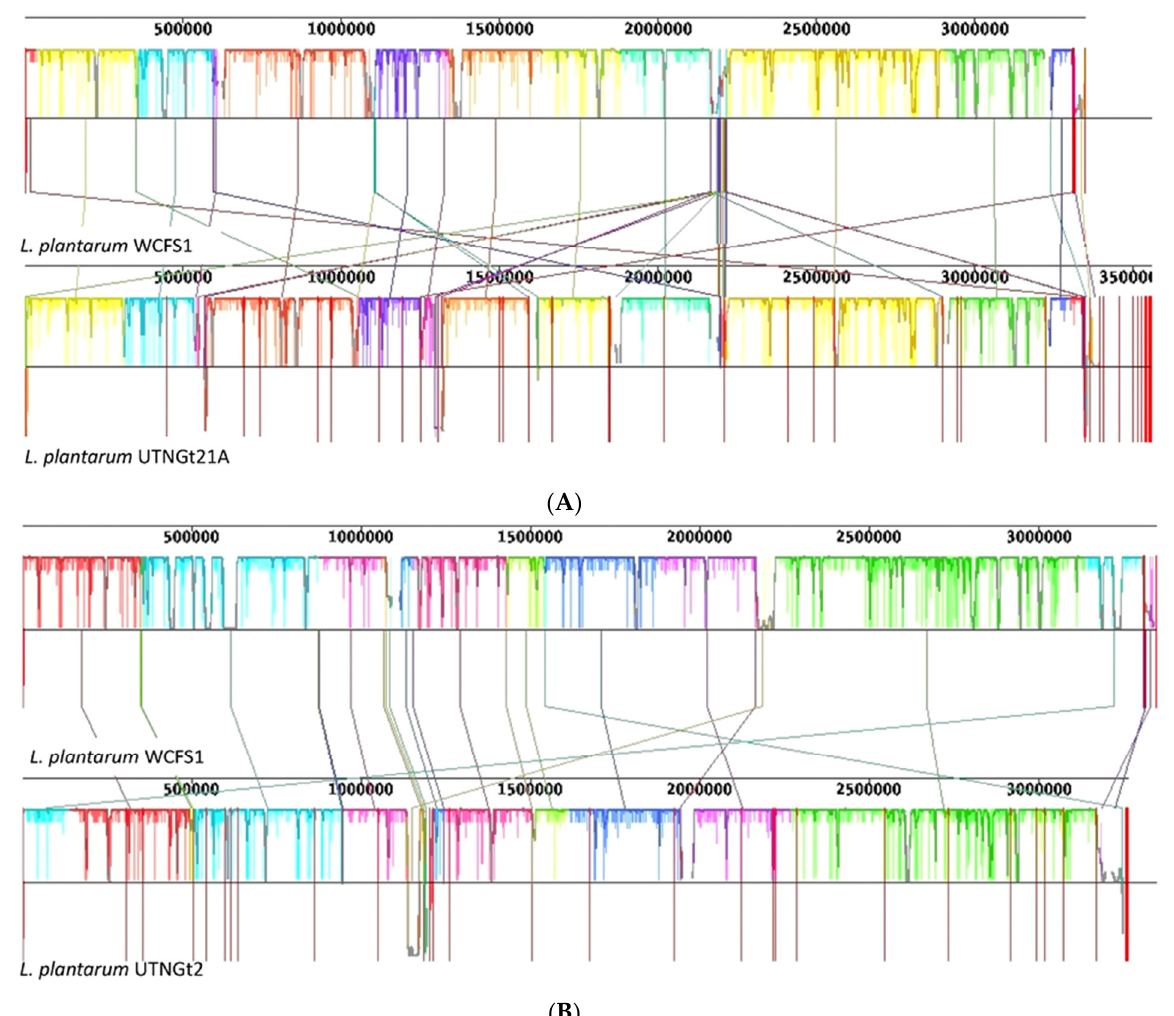
Figure 1. Whole-genome alignments performed using the Mauve contig mover module. The genome of reference strain WCFS1 was aligned with the ( A ) UTNGt21A and ( B ) UTNGt2 draft genomes. White areas indicate low-identity regions between strains. Regions with the same color indicate high-similarity syntenic blocks, and are connected by the same color bars. Red bars indicate boundaries of the original contigs. The numbers above the alignments indicate the nucleotide positions in the WCFS1 genome.